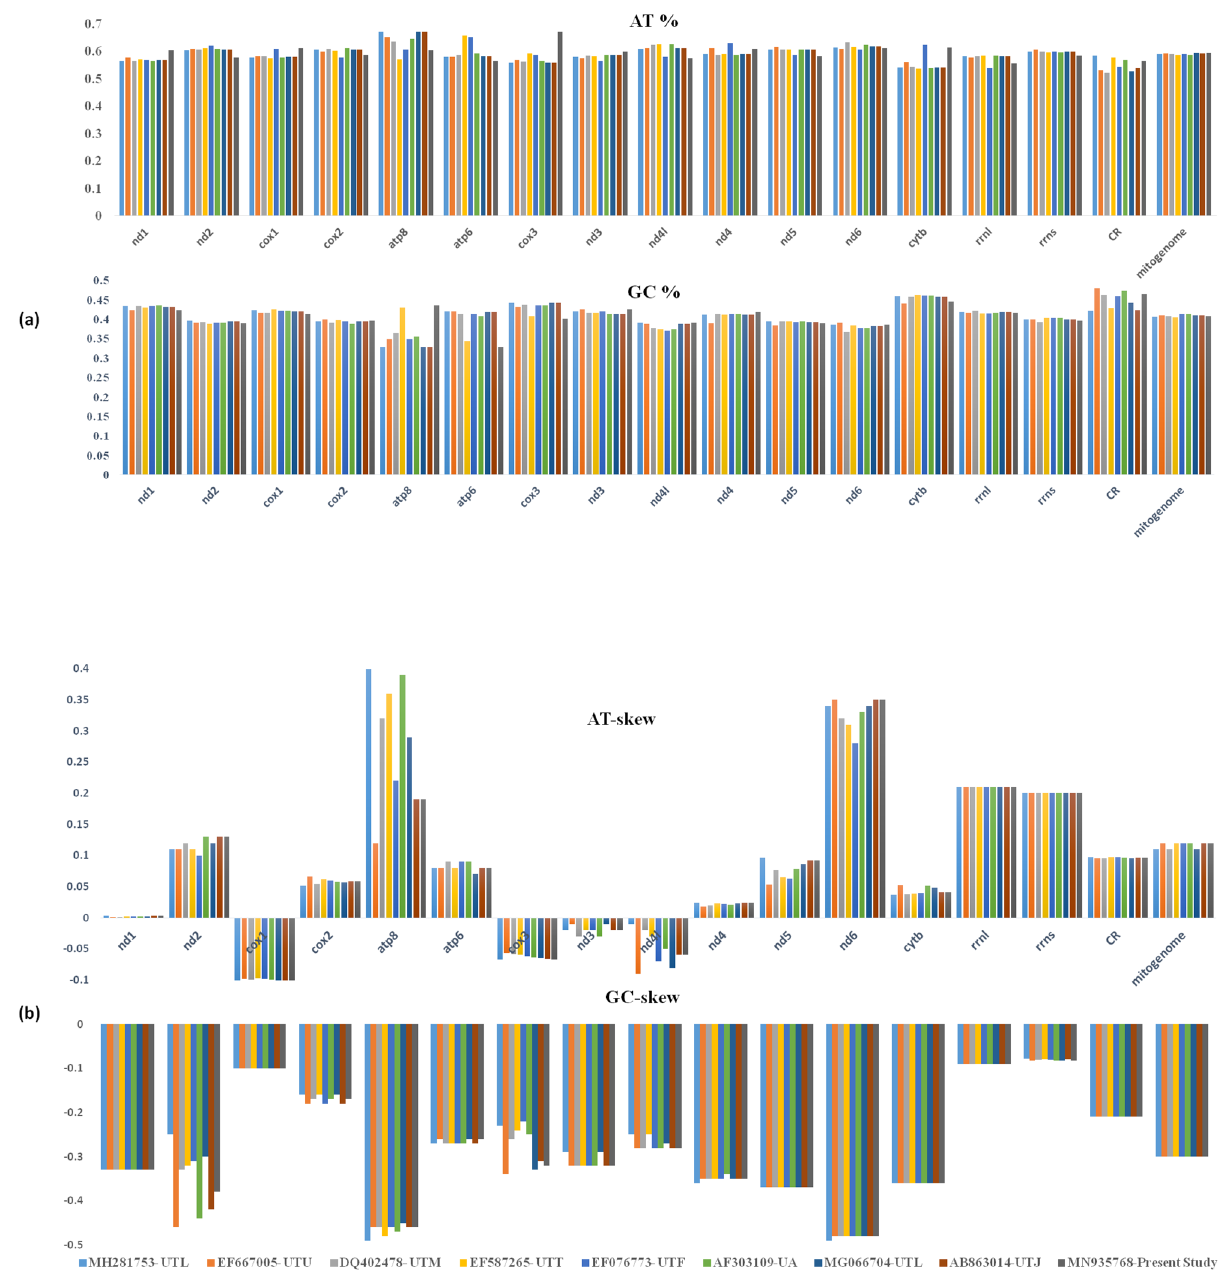
Figure 1. Representation of AT, GC content and skewness of Himalayan black bear with other sub-species of Asiatic black bears. ( a ) AT and GC content ( b ) and